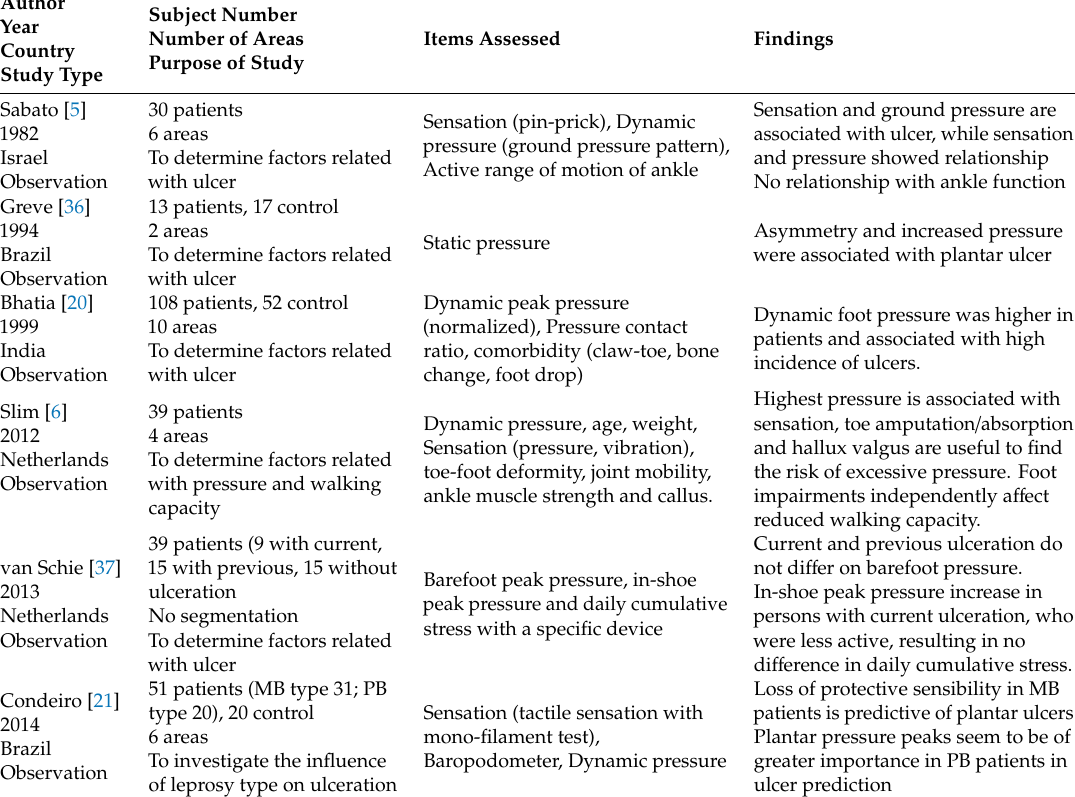
Table 2. Research on the pathogenesis of plantar ulceration utilizing plantar pressure measurement in Hansen’s disease.